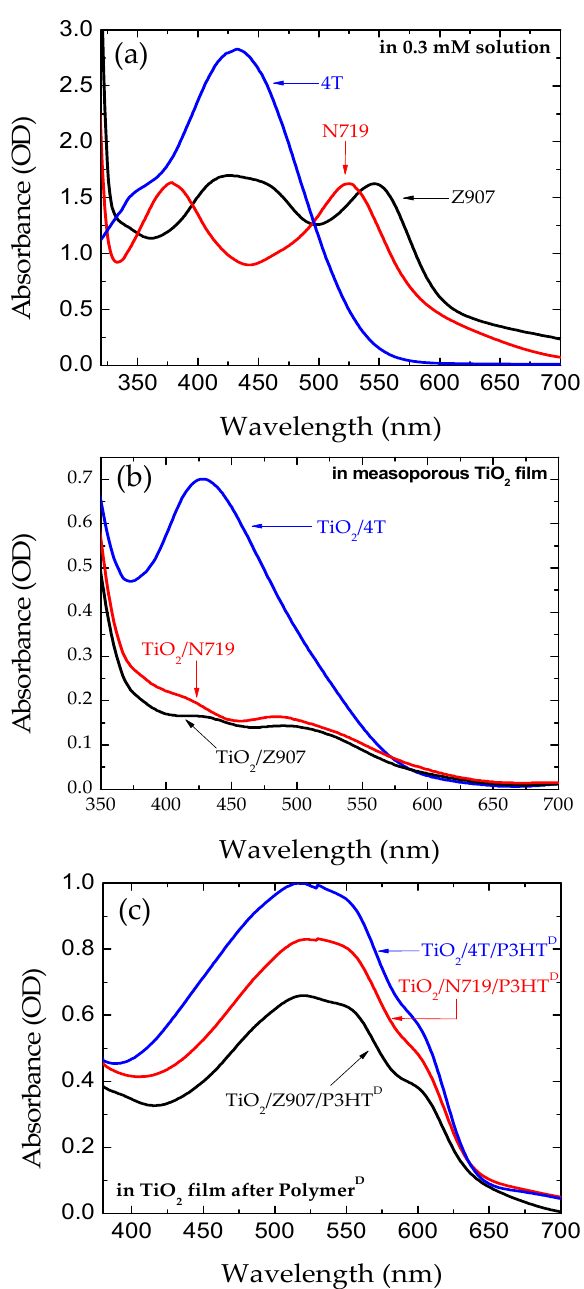
Figure 2. Optical absorption spectra of ( a ) 0.3 mM concentration of dyes dissolved in tert-butanol and acetonitrile solution, ( b ) dye dip-coated nanoporous TiO 2 electrodes, and ( c ) dye polymer dip-coated nanoporous TiO 2 electrodes.